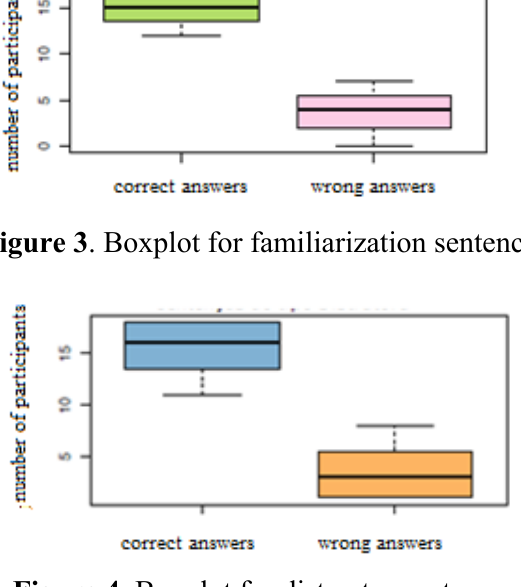
Figure 4 . Boxplot for distractor